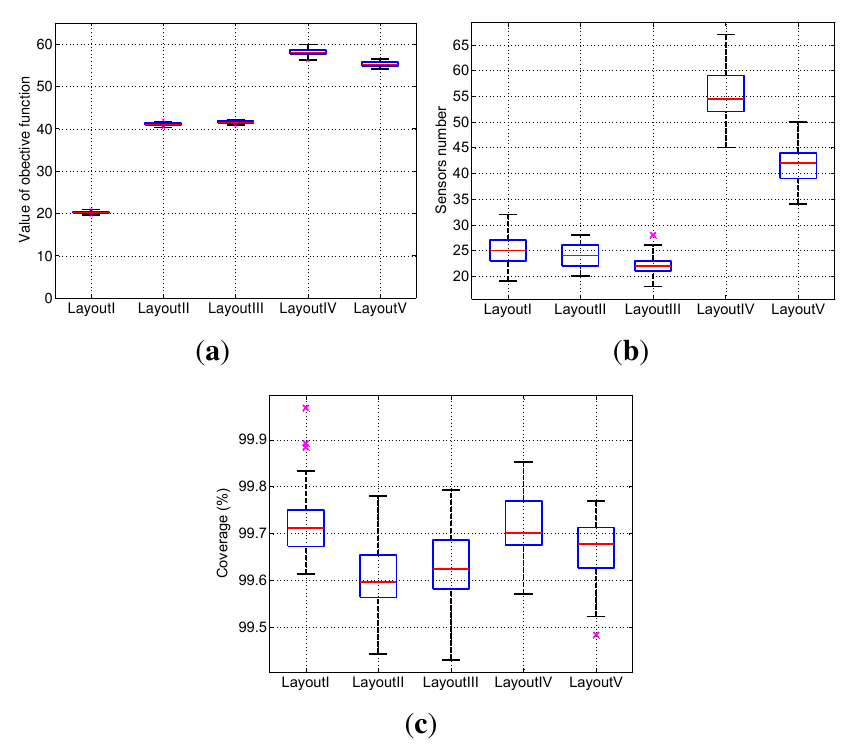
Figure 5. Statistical data of the deployment performance of the layout experiments (a) The objective value. (b) The number of adopted cameras. (c) Effective